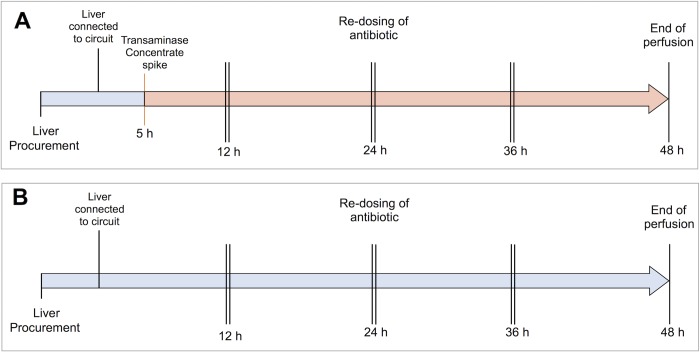
Flow diagrams of the experimental design.(A) Schematic diagram of the ex situ liver perfusion treatment group, perfused for 48 hours. (B) Schematic diagram of control livers perfused for 48 hours.